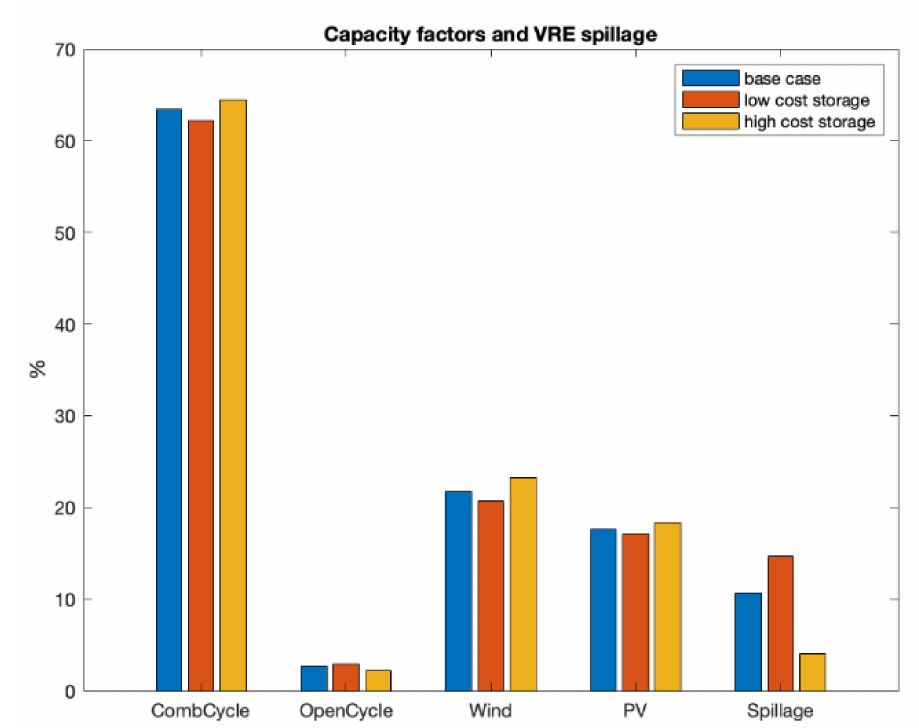
Figure 3. Optimization results. Capacity factors and VRE spillage. Table 4. Optimization results. Total generation: 367.01